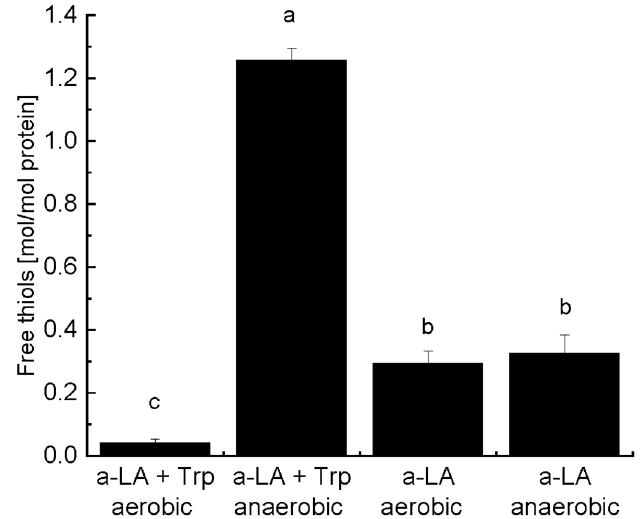
Figure 4. Free thiols (mol/mol apo- α -LA) released in apo- α -LA in the presence or absence of 2.8 mM Trp under aerobic and anaerobic conditions after 24 h of illumination. Mean values ± SD (standard deviation) are shown. Means with different letters are significantly different (one-way ANOVA with a Tukey posthoc test, p < 0.05).